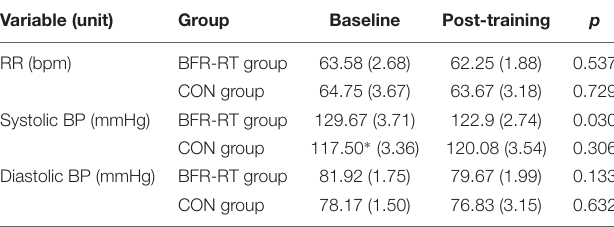
TABLE 1 | Baseline characteristics. TABLE 2 | Resting hemodynamics at baseline and after the intervention